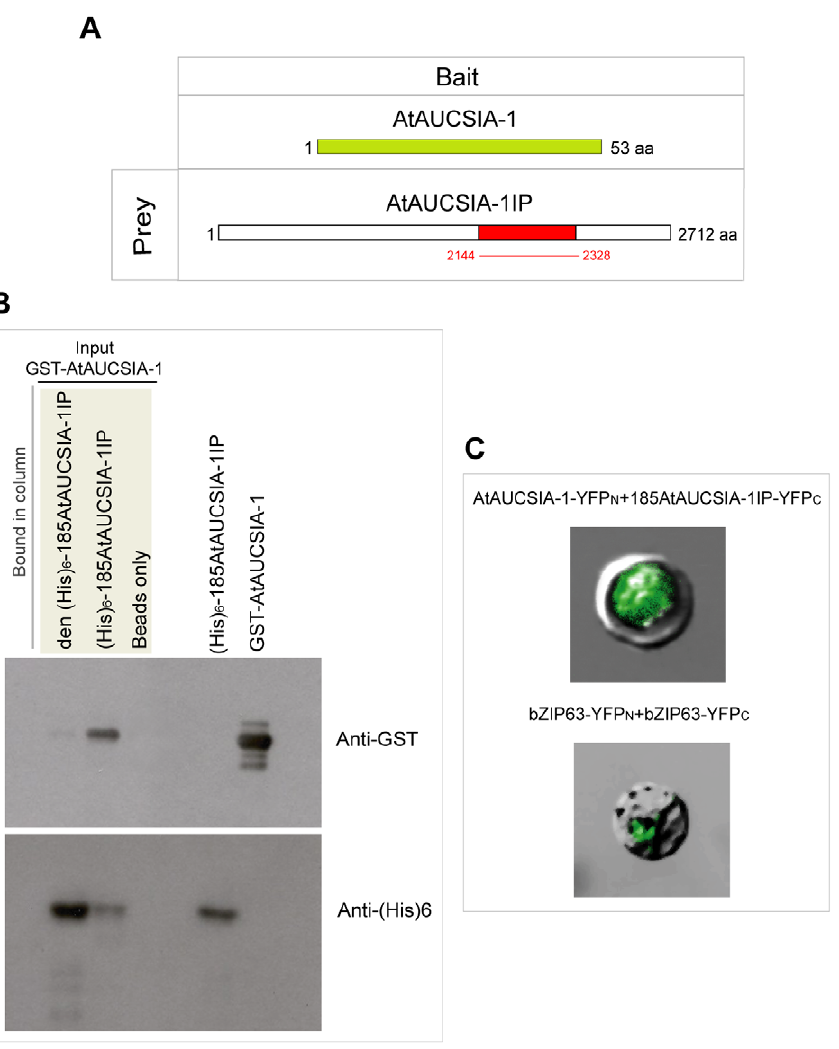
Figure 7. AtAUCSIA-1 interacts with a kinesis-related protein (AtAUCSIA-1IP; i.d. Q9SB74). (A) AtAUCSIA-1IP protein was identified by yeast two-hybrid screening. Five independent clones, corresponding to portions of AtAUCSIA-1IP protein, interacted with the entire AtAUCSIA-1 protein (green box) defining a common overlapping domain of 185 amino acids (red box, 185AtAUCSIA-1IP). (B) The GST-AUCSIA-1 fusion protein interacts with (His) 6 -185AtAUCSIA-1IP in an in vitro binding assay. (His) 6 -185AtAUCSIA-1IP proteins, either in denatured (den (His) 6 -185AtAUCSIA-1IP den) or native form ((His) 6 -185AtAUCSIA-1IP), were bound to nickel-nitrilotriacetic acid magnetic beads. Then, the magnetic beads were incubated in the presence of purified GST-AUCSIA-1. The protein fractions bound to magnetic beads were eluted, separated by SDS-PAGE, and detected by Western blot using either anti-GST (upper panel) or anti-His antibodies (lower panel). (His) 6 -185AtAUCSIA-1IP coated beads pulled down GST-AUCSIA- 1. Beads alone were used as negative control to test non specific interactions. Purified (His) 6 -185AtAUCSIA-1IP and GST-AUCSIA-1 proteins were used as protein markers in SDS-PAGE. (C) BiFC experiments were performed in A. thaliana mesophyll protoplasts by coexpression of translational fusions of AtAUCSIA-1 and 185AtAUCSIA-1IP with either the C- or N-terminal halves of YFP (YFP C or YFP N ). AtAUCSIA-1 (AtAUCSIA-1-YFP N ) interacts with 185AtAUCSIA-1IP (185AtAUCSIA-1IP-YFP C ) protein in the cytoplasm (upper panel). An identical result was obtained by swapping the two YFP portions (data not shown). For positive control, the A.thaliana leucine zipper bZIP63 fused to YFP N and YFP C was used (lower panel) [102]. The dimer of bZIP63 was located in the nucleus (lower). The fluorescence signals were detected by a confocal laser scanning microscope (Fluoview FV1000;